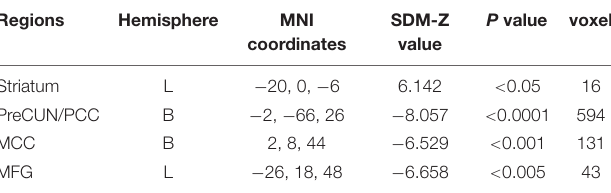
FIGURE 3 | Results of SDM-PSI meta-analysis. Yellow represents the brain region with increased activity. Blue represents the brain region with decreased activity. preCUN, precuneus; PCC, posterior cingulate cortex; MCC, middle cingulate cortex; MFG, middle frontal gyrus. TABLE 4 | Results of meta-analysis were selected for following spDCM